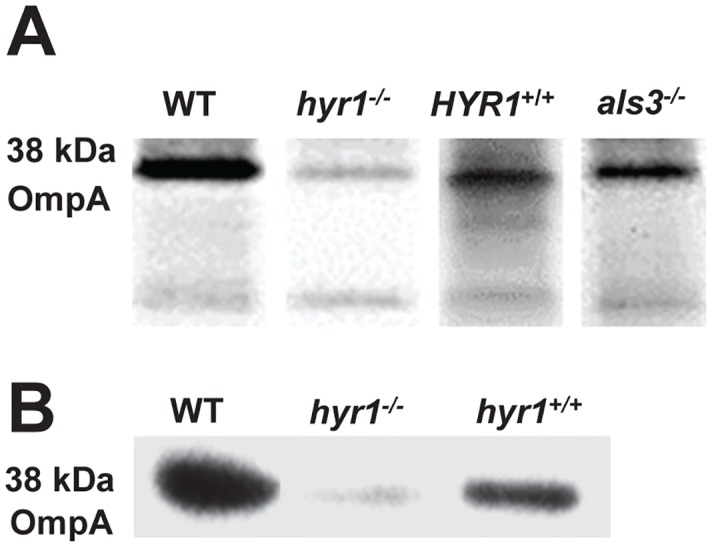
Acinetobacter OmpA is the ligand to Candida Hyr1p.Acinetobacter biotin-labeled cell wall proteins that bound to C. albicans wild-type, hyr1/hyr1, hyr1/hyr1+HYR1, or als3/als3 hyphae were separated on SDS-PAGE, probed with anti-biotin antibody, and the hybridized bands were identified by Mass spectrometry. C. albicans wild-type or hyr1/hyr1+HYR1 complemented hyphae bound a major band at 38 kDa which was identified as OmpA by MS/MS analysis (A). In contrast, the hyr1/hyr1 mutant had severe reduction in its ability to bind OmpA. C. albicans Als3p was not found to be a receptor as proteins equally bound to als3/als3 mutant strain (A). To confirm the identity of the 38 kDa band, blots were probed with an anti-OmpA antibody, which confirmed that the 38 kDa proteins were indeed OmpA (B).